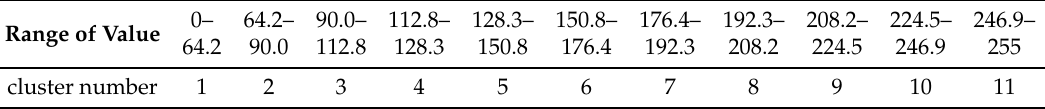
Table 3. Cluster number and the range of optical characteristic values.